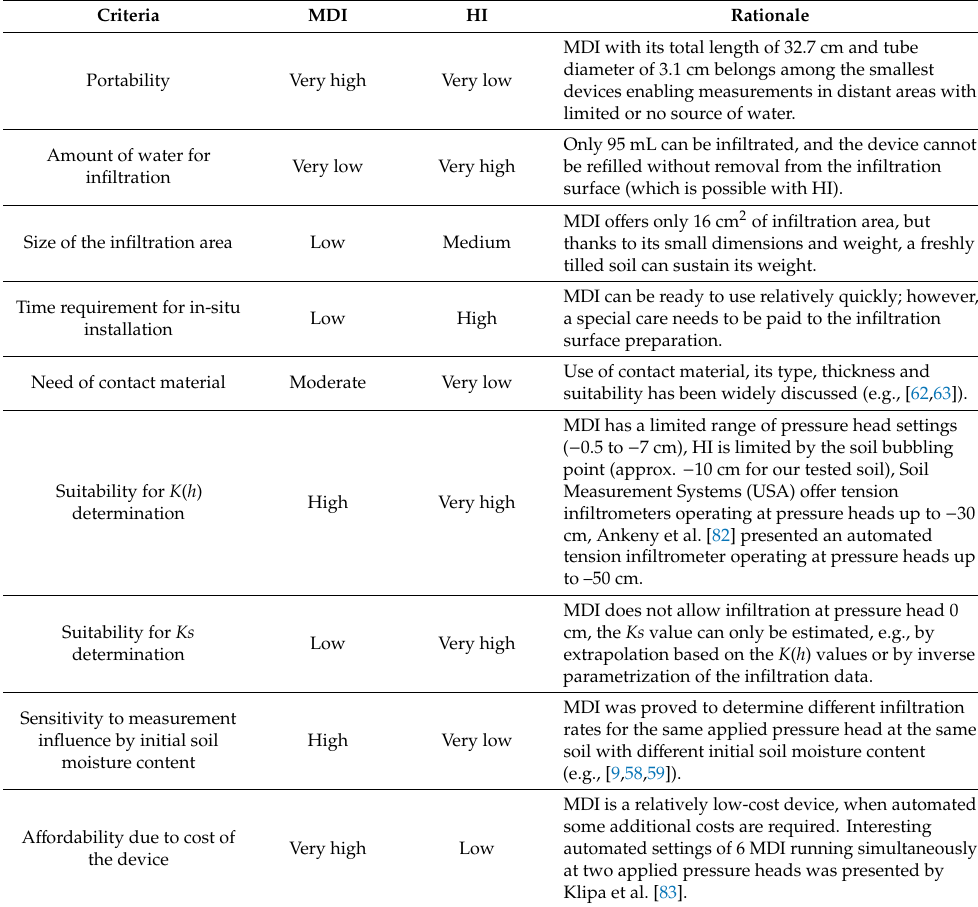
Table 5. Overall evaluation of MDI, comparison to HI and short justification of presented data. Used scale: Very low–Low–Moderate–High–Very